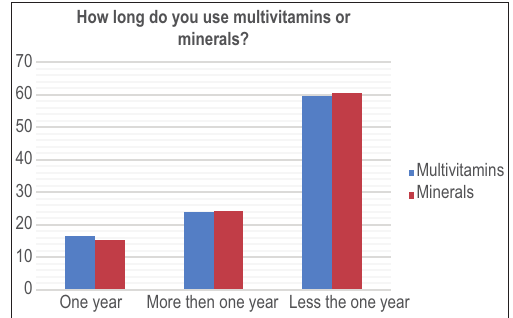
FIGURE 2. Prevalence of consuming vitamin and mineral